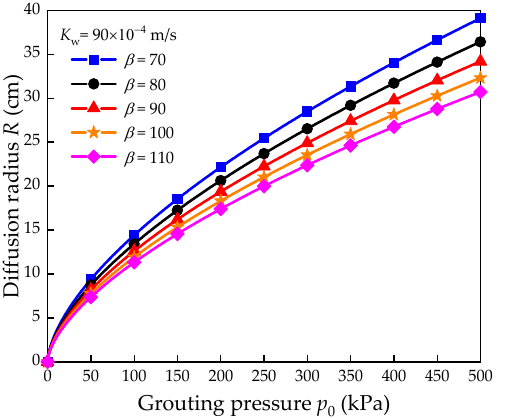
Figure 7. Influence of slurry viscosity on diffusion radius, which was drawn by Equation (44).